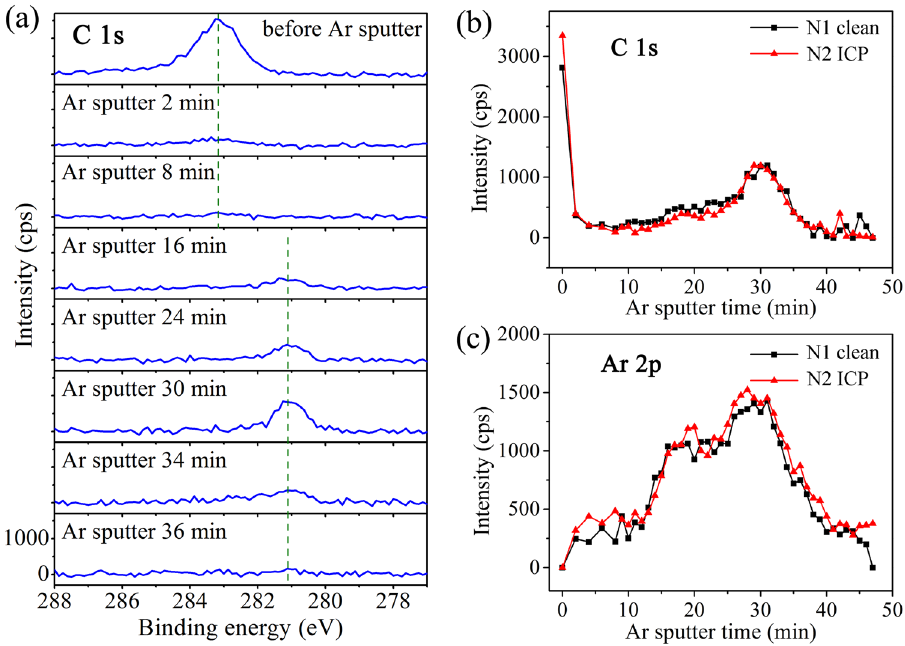
Figure 5. Depth profile of C and Ar components. ( a ) C 1 s core level spectra during sputtering with binding energy in the range of 277 eV–288 eV. ( b ) Depth profile of C 1 s component. ( c ) Depth profile of Ar 2p